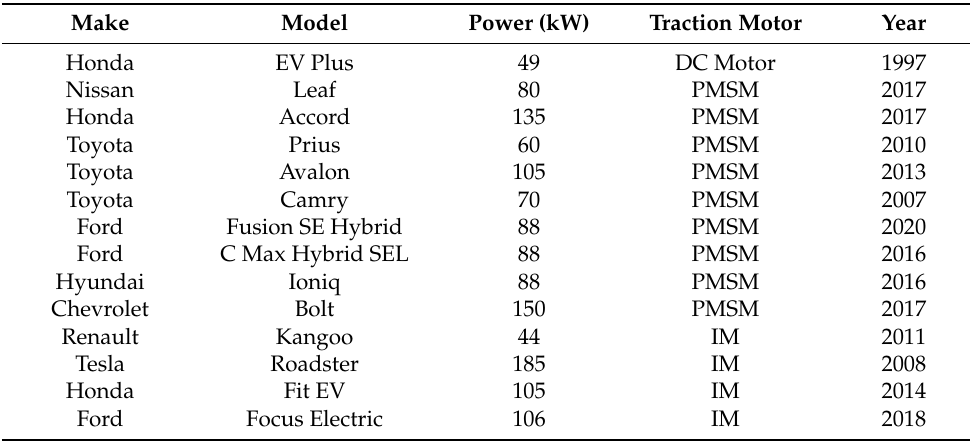
Table 1. Industrial uptake of EV and HEV traction motors [9,11,29 – 31].